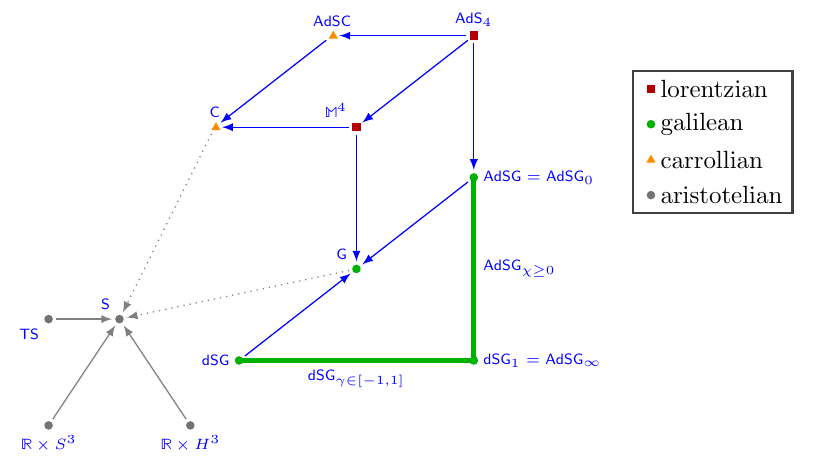
Figure 1 . Homogeneous superspaces and their limits. (Numbers are hyperlinked to the corre- sponding superspaces in table 14.)